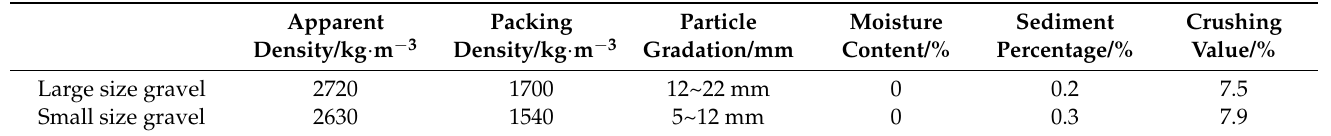
Table 1. Physical properties of crushed stone.